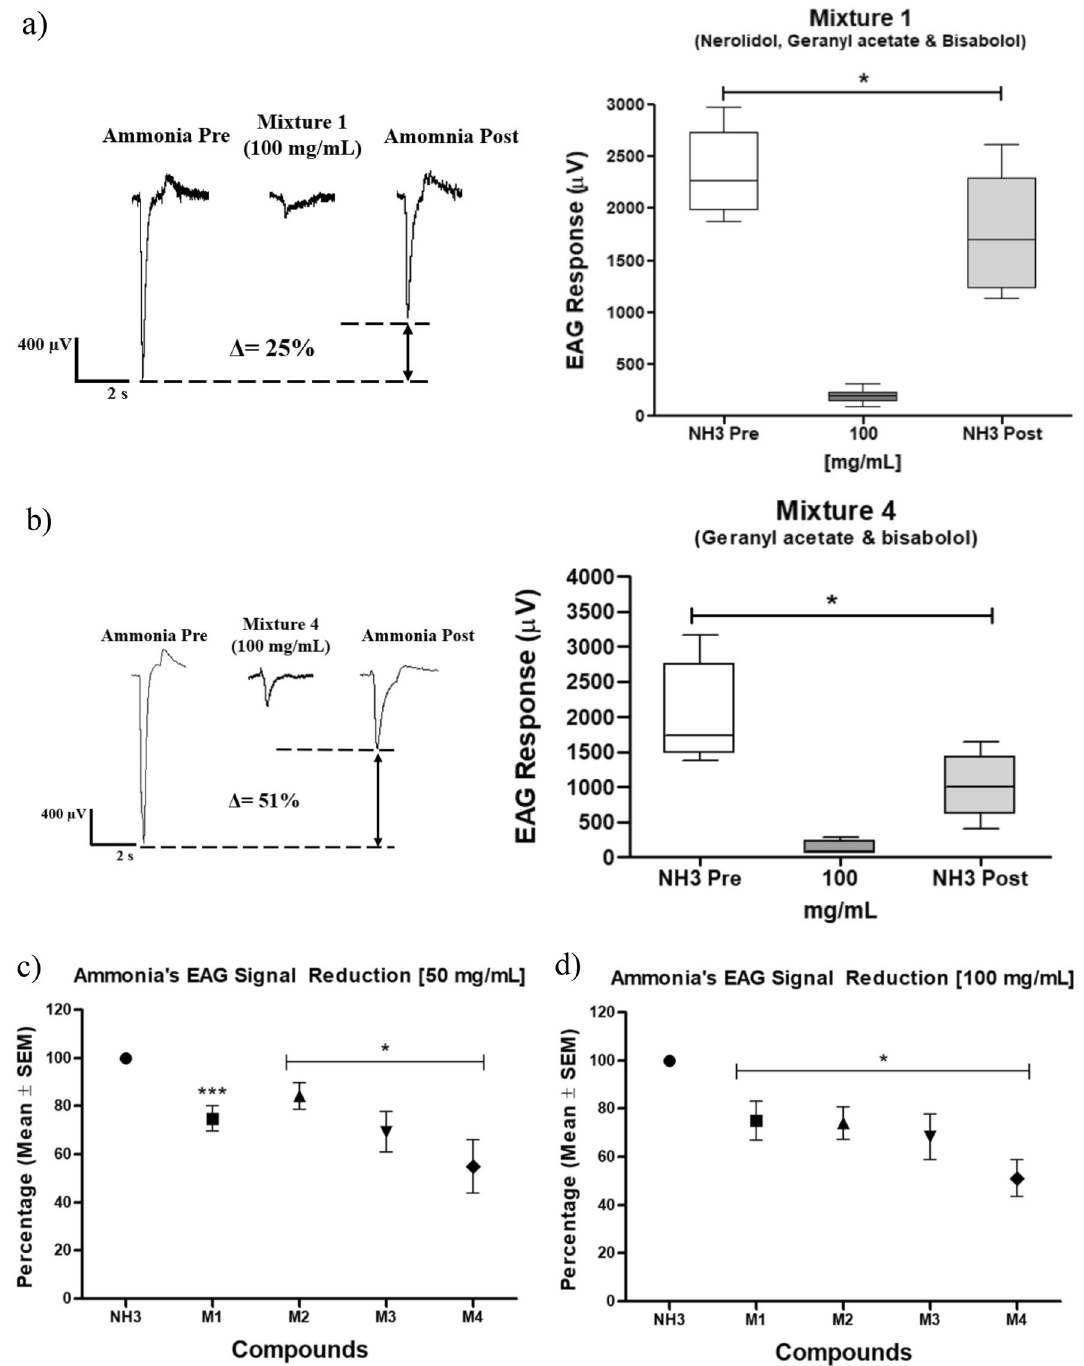
Figure 4. EAG signals patterns and percentage changes in the pre- and post-treatment ammonia signal after applying ( a ) mixture 1 [100 mg/mL] (geranyl acetate, α-bisabolol, and nerolidol), ( b ) mixture 4 [100 mg/mL] (geranyl acetate and α-bisabolol) with a pre- and post-treatment pulse of ammonia. ( c ) and ( d ) Percentual reduction of ammonia EAG signal summary for each mixture (mean average ± standard deviation SEM) in the concentrations 50 and 100 mg/mL, respectively. (NH 3 : ammonia, M1: mixture 1, M2: mixture 2, M3: mixture 3, M4: mixture 4). (*) Indicates statistically significant differences between pre- and post-treatment ammonia signals for the mixtures mentioned. One way ANOVA, (*) p < 0.05, post hoc Tukey test. Mixture 2 (geranyl acetate and nerolidol), mixture 3 (nerolidol and